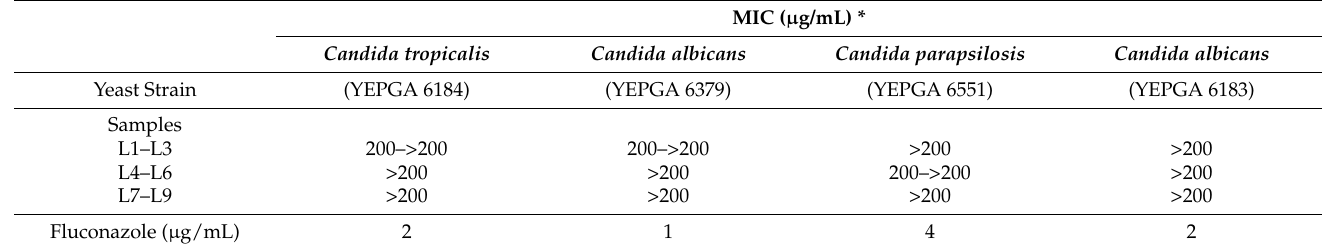
Table 7. Minimal inhibitory concentrations (MICs) of F. officinalis samples against yeast isolates. MIC ( µ g/mL) *